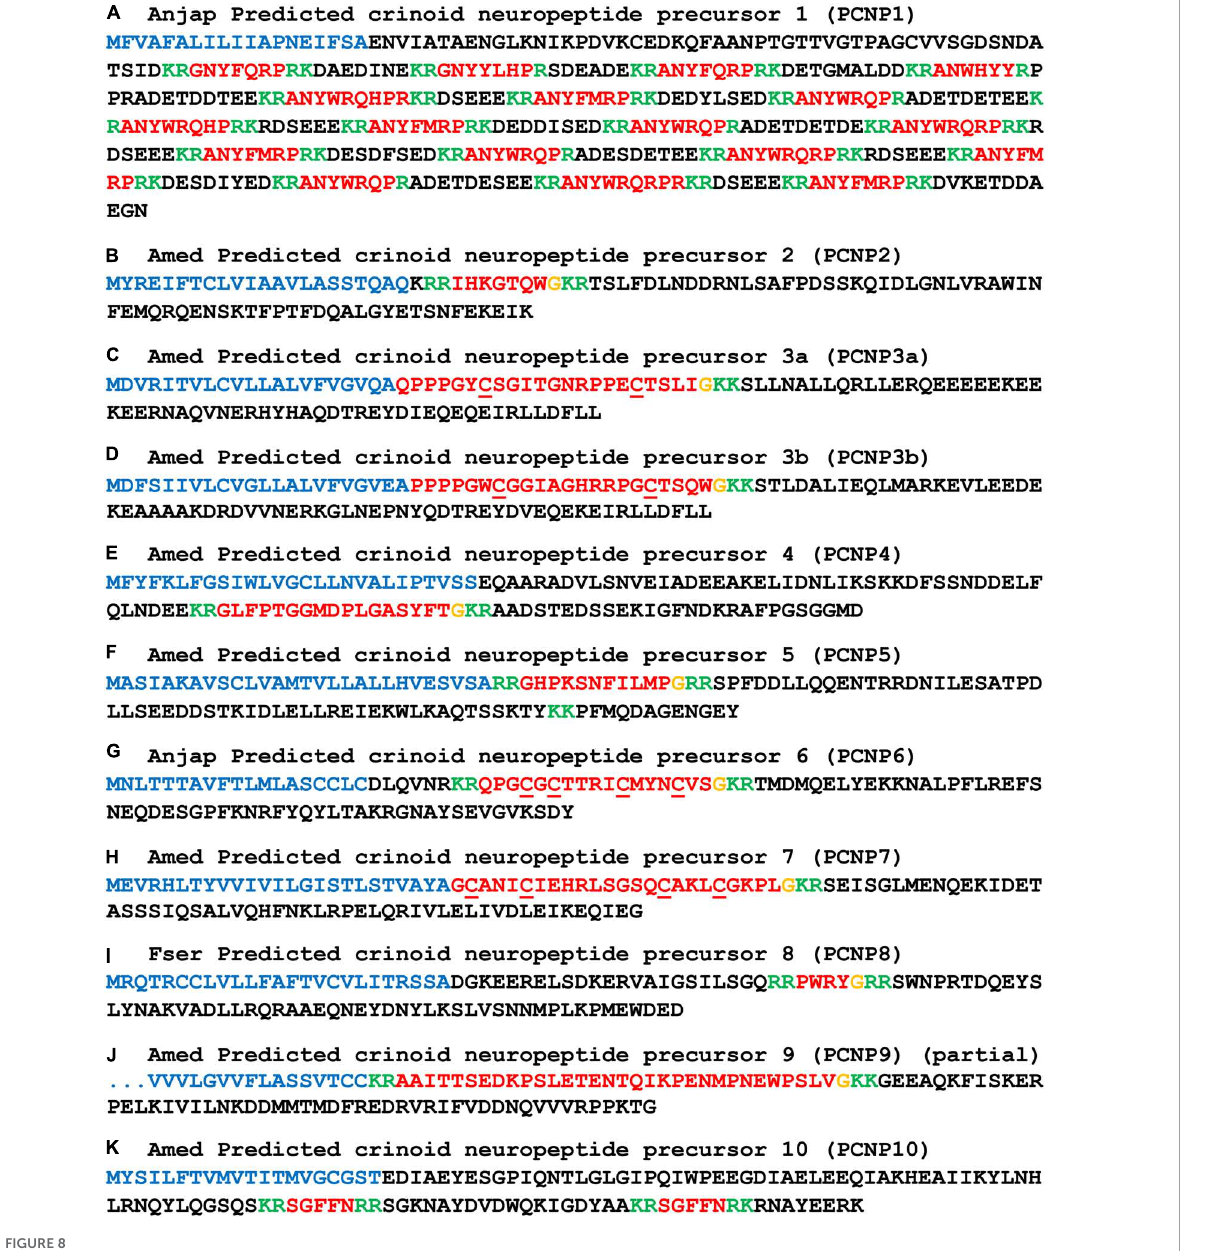
FIGURE8 Other predicted crinoid neuropeptide precursors (PCNP1-10). Neuropeptide precursor sequences from Antedon mediterranea (Amed) are shown, with the exception of those precursors that were partially or not identified in this species and where sequences from Anneissia japonica (Anjap) or Florometra serratissima (Fser) are shown. The predicted signal peptide is shown in blue, predicted monobasic/dibasic cleavage sites are shown in green and predicted neuropeptides are shown in red, but with C-terminal glycine residues that are potential substrates for post-translational amidation shown in orange. The DNA sequences of transcripts encoding these precursors are shown in Supplementary File 2